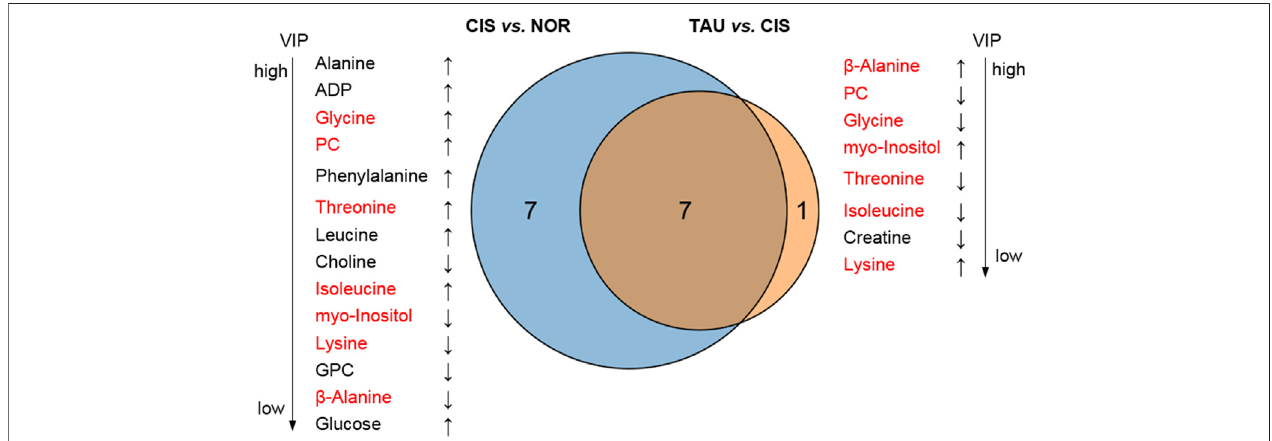
FIGURE 7 | Venn diagrams of characteristic metabolites identi fi ed from pairwise comparisons of CIS vs. NOR and TAU vs. CIS. Characteristic metabolites were determined by a combination of the signi fi cant metabolites identi fi ed from the PLS-DAs (VIP > 1) and differential metabolites identi fi ed from the univariate analyses ( p < 0.05). The upward arrow and downward arrow denote that the difference between A and B is positive (A is increased compared to (B) ) and negative (A is decreased compared to (B) ), respectively. The metabolites in red font refer to shared characteristic metabolites in the two comparisons.